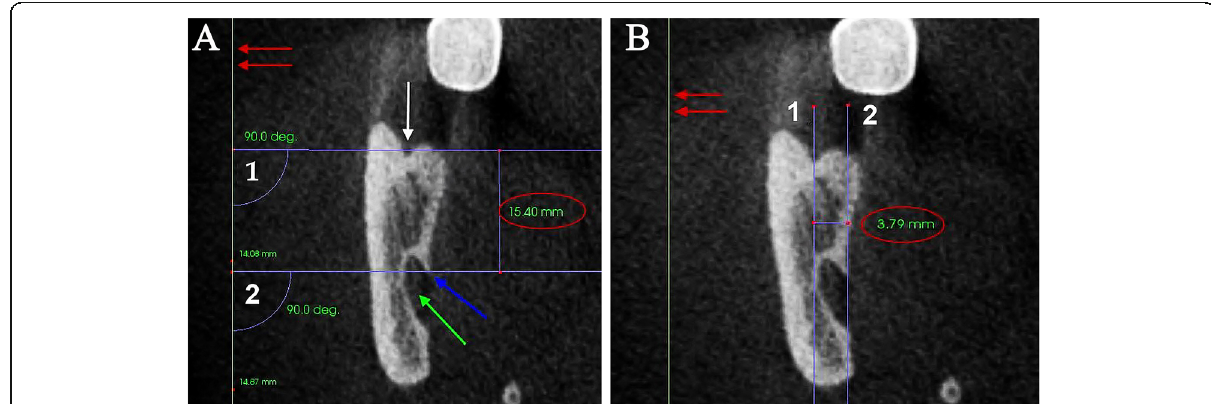
Fig. 3 Linear measurements between the MF and RMF in anteroposterior and mediolateral directions. a Axial cut showing the red arrows pointing to the sagittal plane reference line, the green arrow to the MF, and the blue arrow to the lingula. (1) Line drawn from the middle of the RMF perpendicular to the sagittal plane reference line. (2) Line drawn from the middle of the MF perpendicular to the sagittal plane reference line. The linear measurement between the RMF and MF in anteroposterior direction is 15.4 mm. b Axial cut showing the red arrows pointing to the sagittal plane reference line. (1) Line drawn from the middle of the RMF parallel to the sagittal plane reference line. (2) Line drawn from the middle of the MF parallel to the sagittal plane reference line. The linear measurement between the RMF and MF in mediolateral direction is 3.79